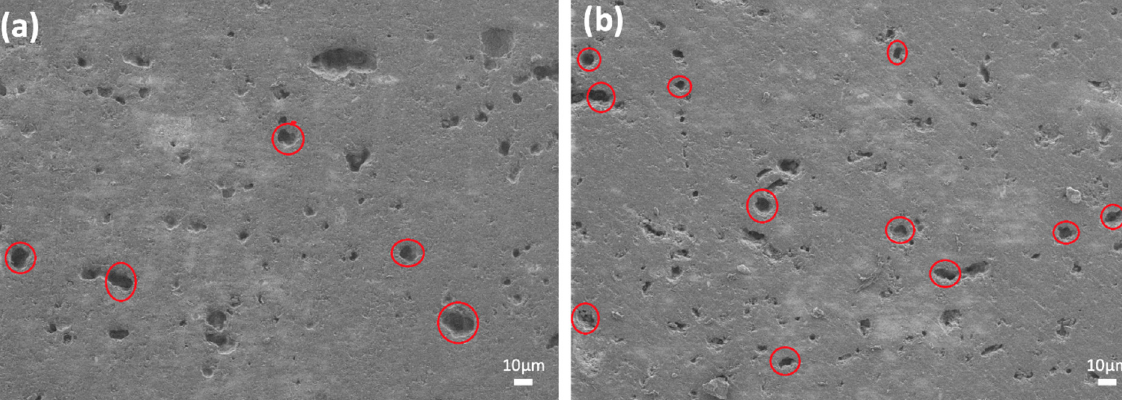
Figure 5. SEM images of the sintered glass-ceramics at 1.00 KX: ( a ) 30Al-O and ( b ) 40Al-O.